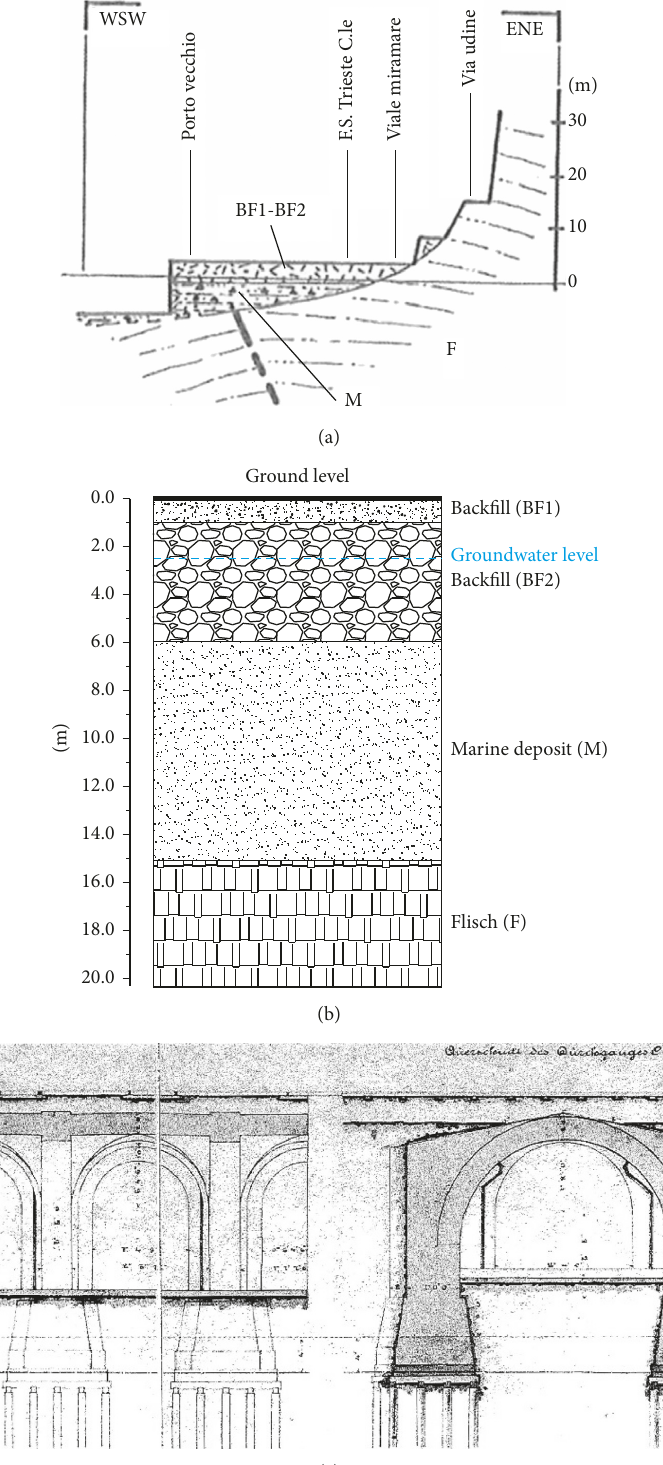
Figure 3: Geological characterization of the ground: (a) vertical section; (b) geotechnical interpretation of one of the probings executed; (c) the building foundations of the storehouses as depicted on the original 1850